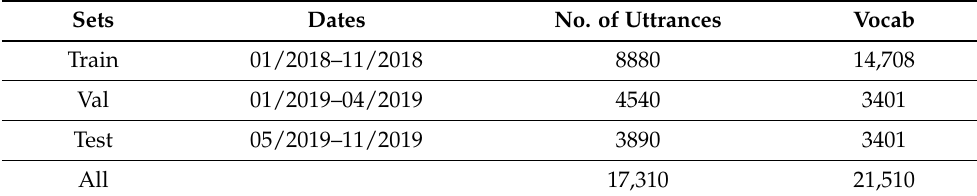
Table 1. Division of datasets into training, validation, tests and partition of sentences and vocabulary for three